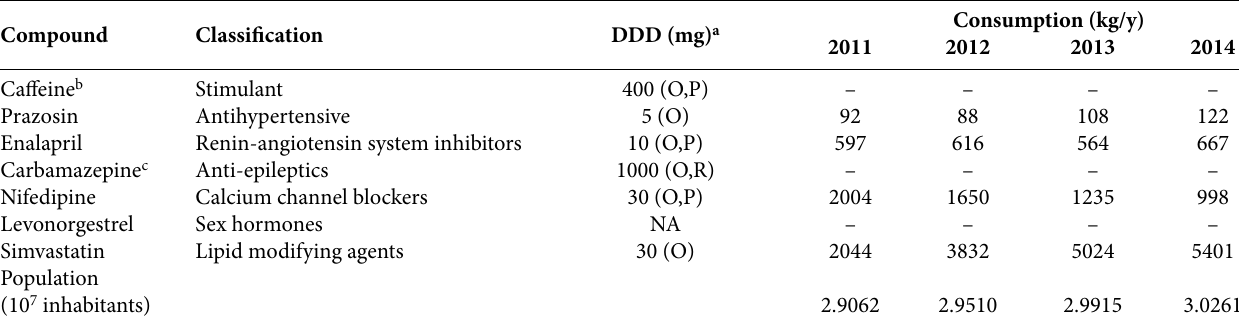
Table 1. Defined daily doses and the consumption of the selected pharmaceuticals in Malaysia 2011-2014